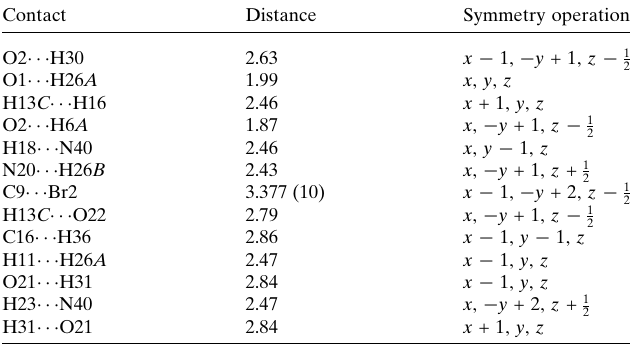
Table 2 Summary of short interatomic contacts (A˚ ) in the title compound. Contact Distance